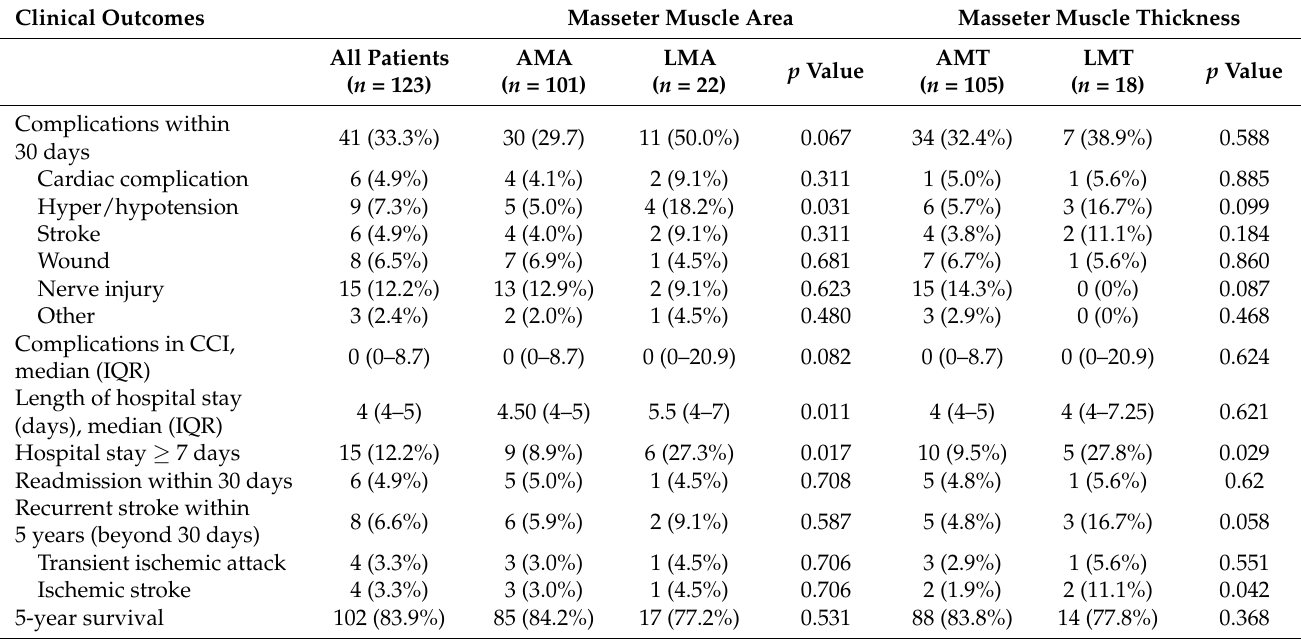
Table 2. Comparison of clinical outcomes by presence of adequate or low masseter muscle area and adequate or low masseter muscle